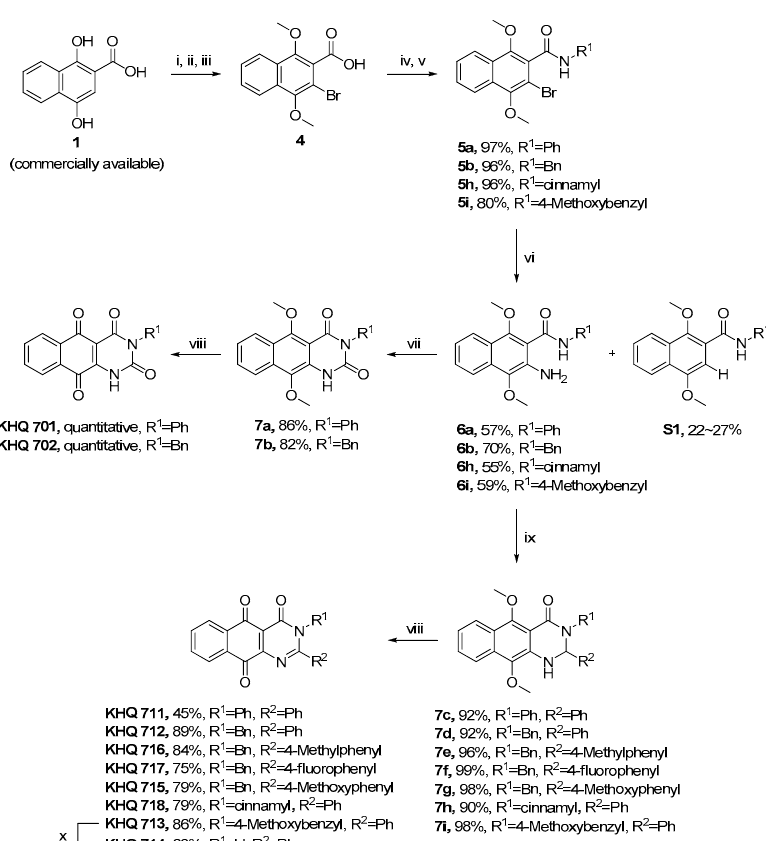
Figure 2. Synthesis of new pyrimidinone-fused 1,4-naphthoquinones. Reagents and conditions: (i)